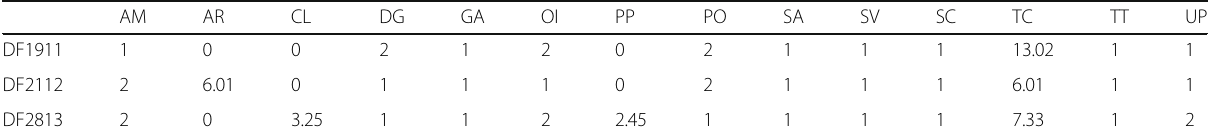
Table 2 Formulation composition (ratio)